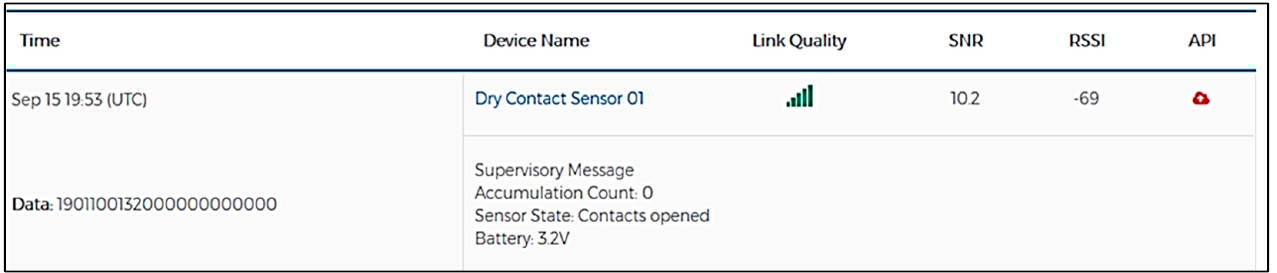
Figure 8. Sample of received sensor data packet.